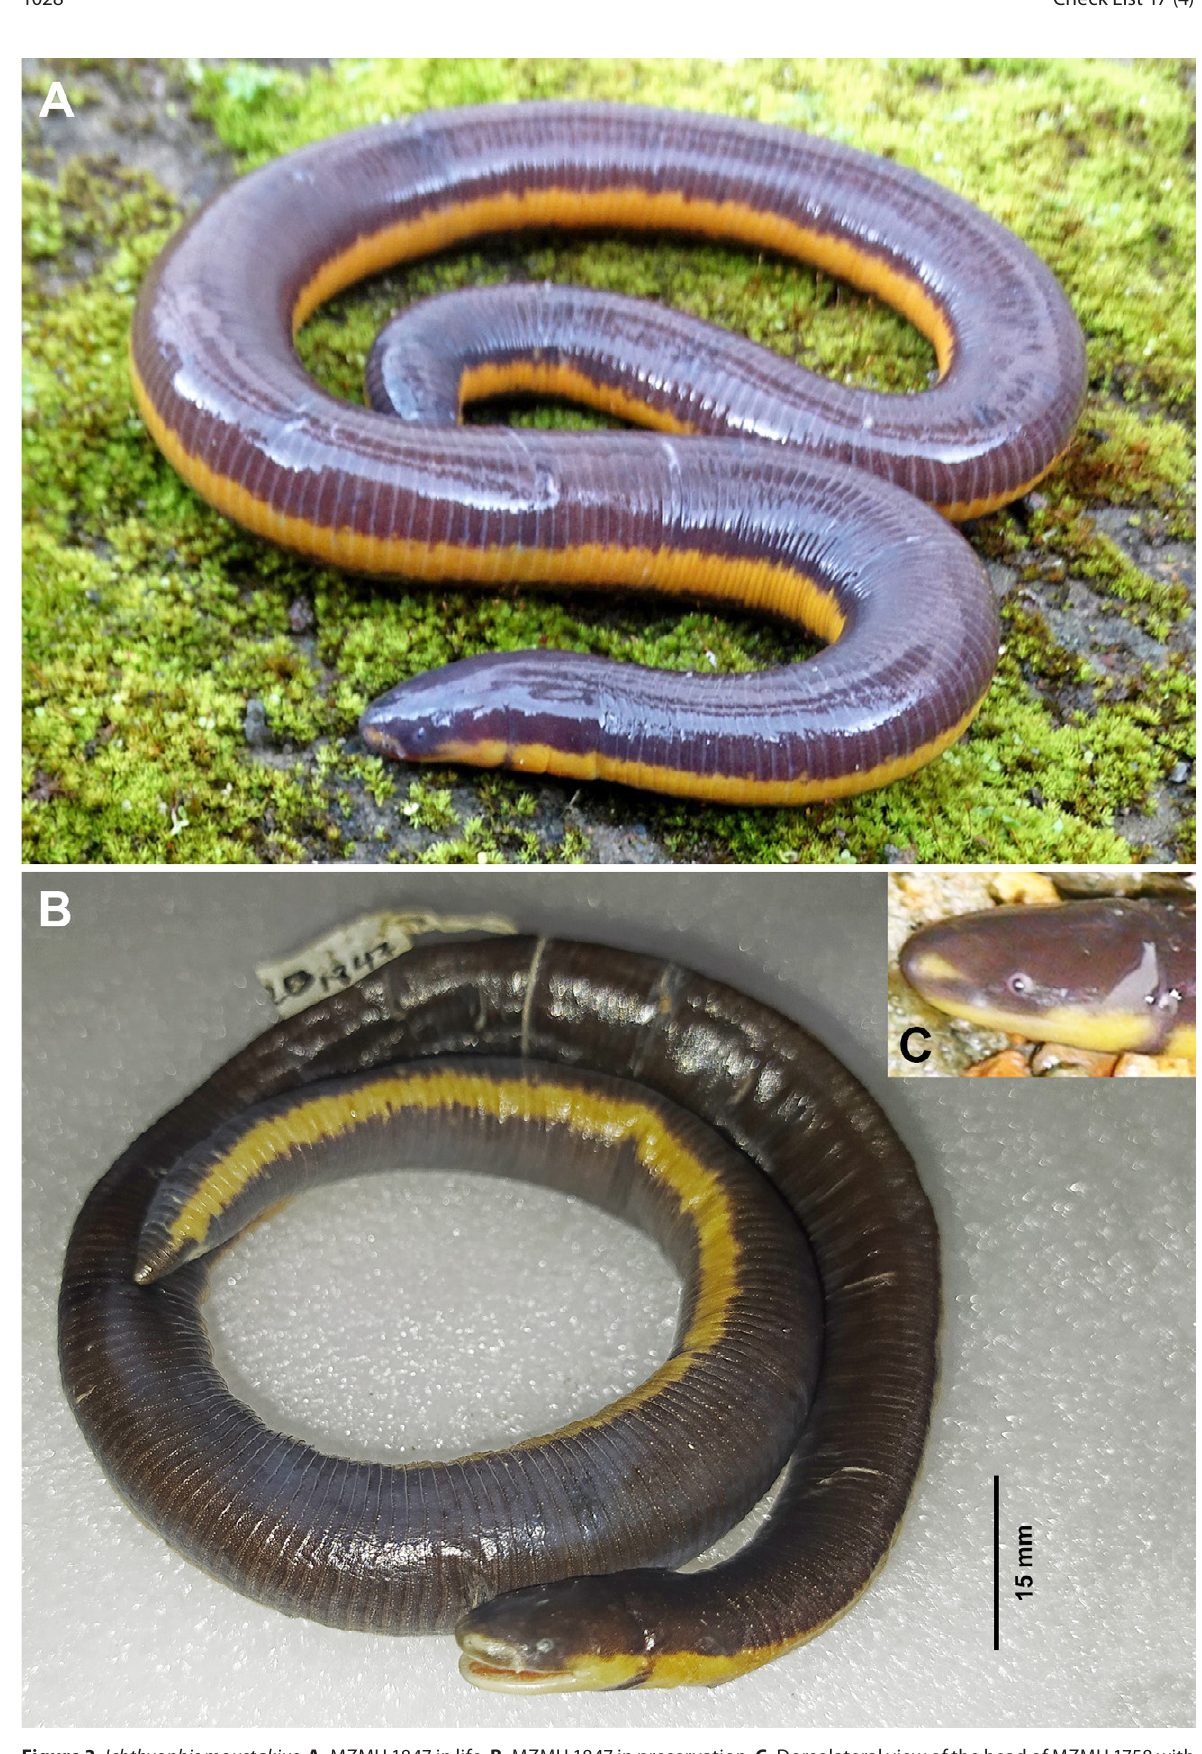
Figure 3. Ichthyophis moustakius. A. MZMU 1847 in life. B. MZMU 1847 in preservation. C. Dorsolateral view of the head of MZMU 1758 with the characteristic moustache-like, arched, yellow stripe between tentacular aperture and